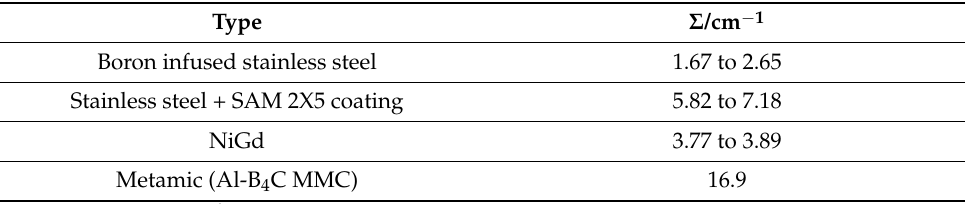
Table 7. Absorption cross sections of different materials